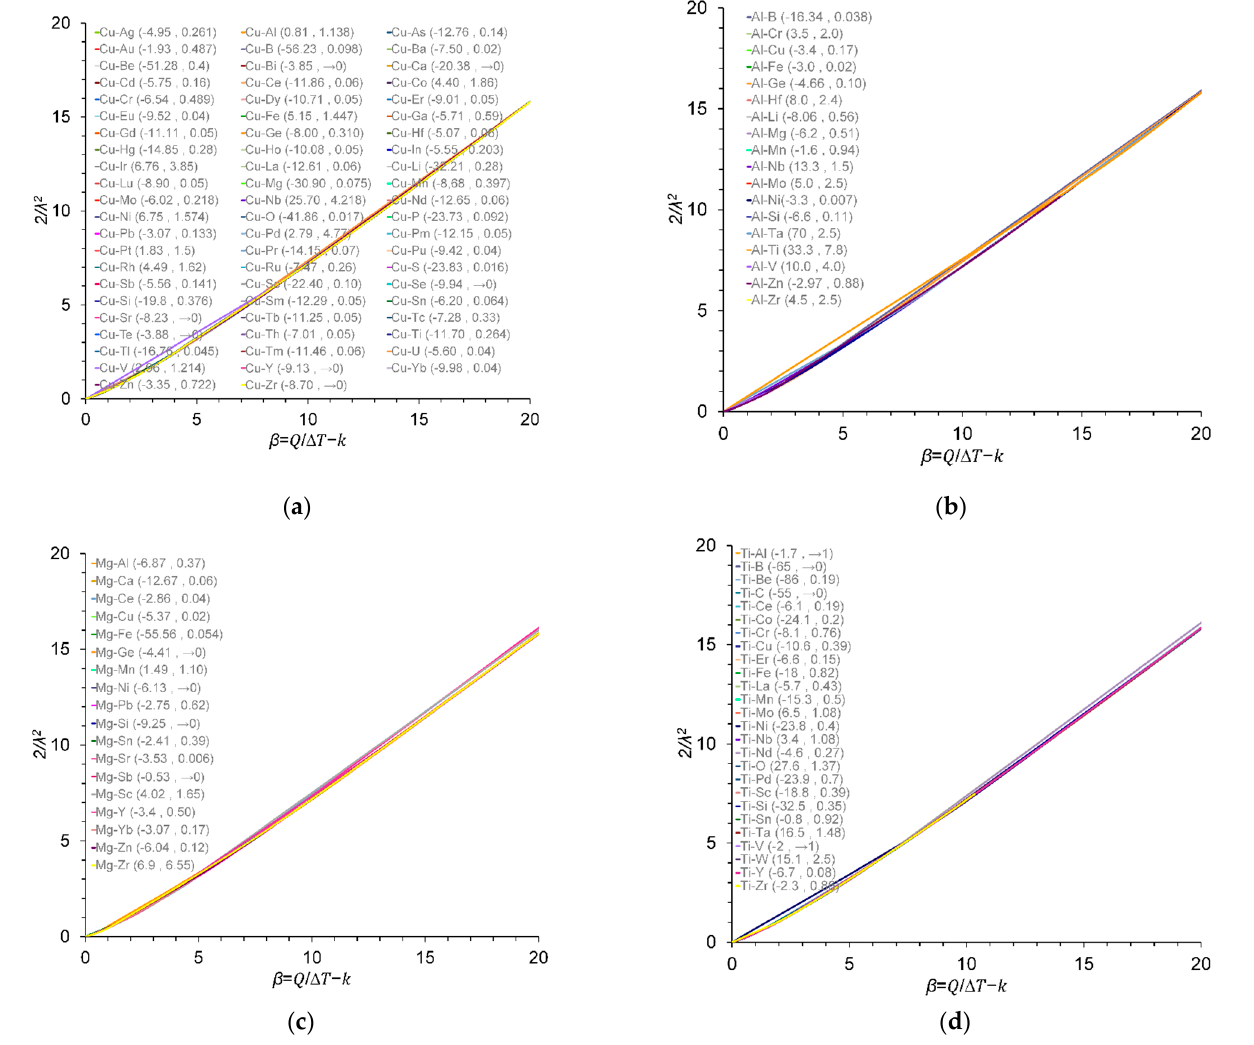
Figure 2. Variation in 2/ λ 2 values with β at ∆ T = 0.5 K for ( a ) Cu–X; ( b ) Al–X; ( c ) Mg–X; and ( d ) Ti–X binary alloys. The m and k values are given in parentheses ( m and k ), data from [9,22,23,25–31]. The m and k values for the Al–B binary alloy were calculated in this work.